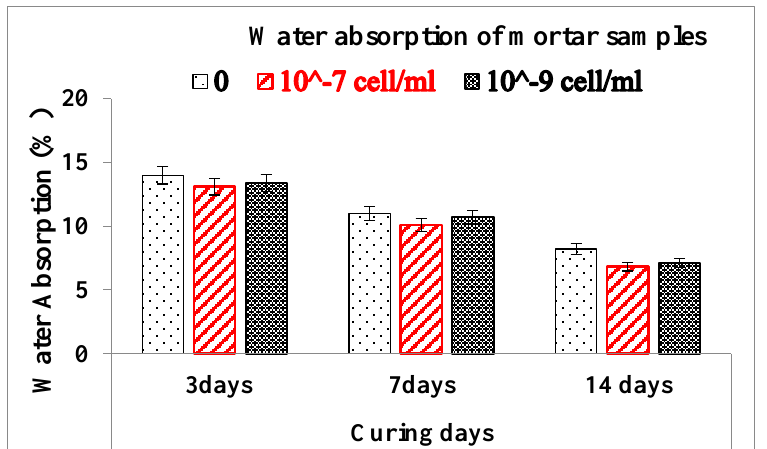
Figure 13. Water absorption of mortar samples: conventional mortar and Self-Healing Mortar.